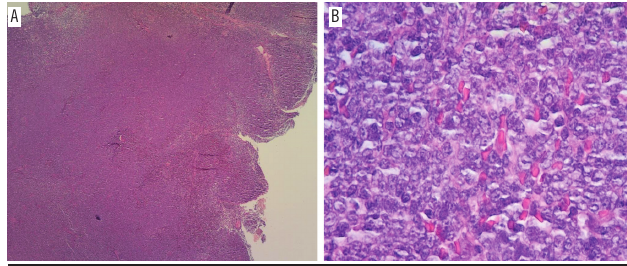
fIgure – A) Photomicrograph (HE, 2×): cervical lymph node biopsy; B) photomicrograph (HE, 40×): cervical lymph node biopsy demonstrating atypical proliferation HE: hematoxylin and